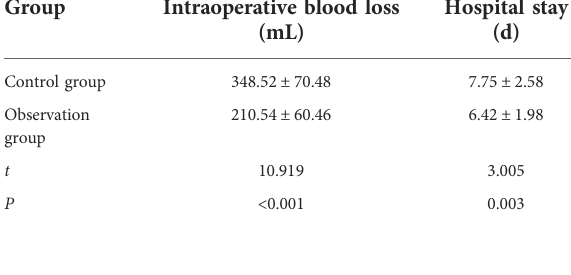
TABLE 2 Comparison of intraoperative blood loss and hospital stay between two groups.